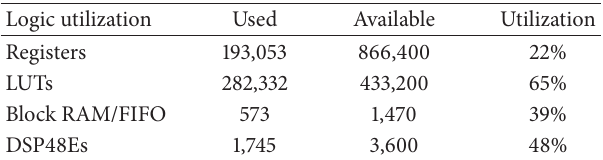
Table 1: Resources